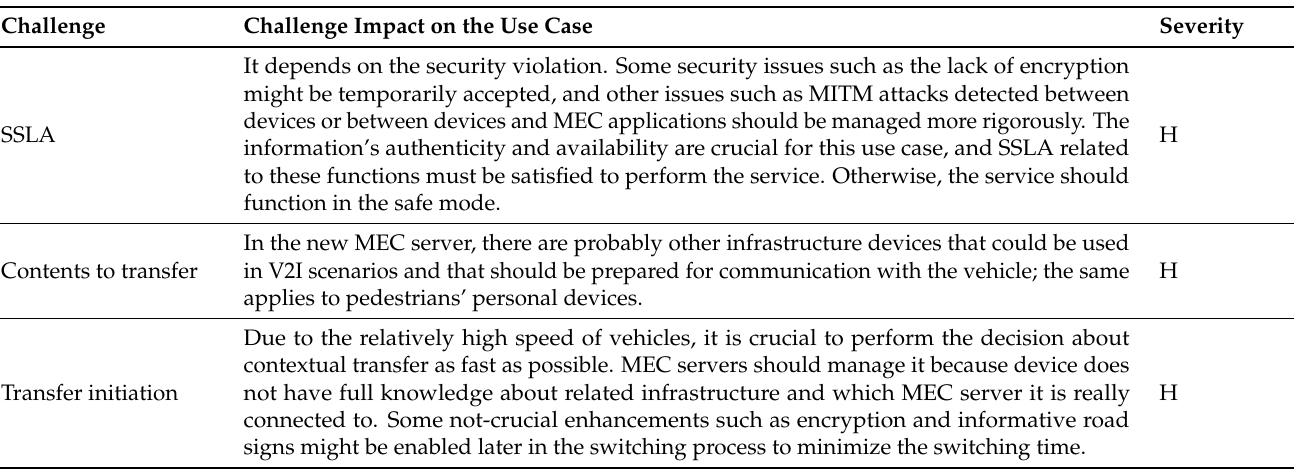
Table 12. Challenges in the V2X communication use